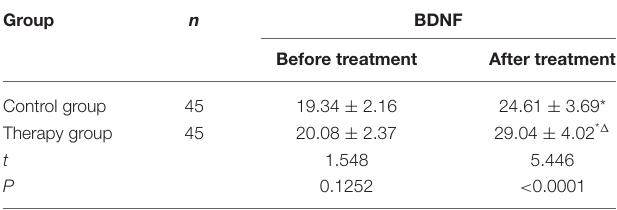
TABLE 6 | Comparison of serum BDNF content before and after treatment in the two groups (M ± SD, ng/mL). Group n BDNF Before treatment After